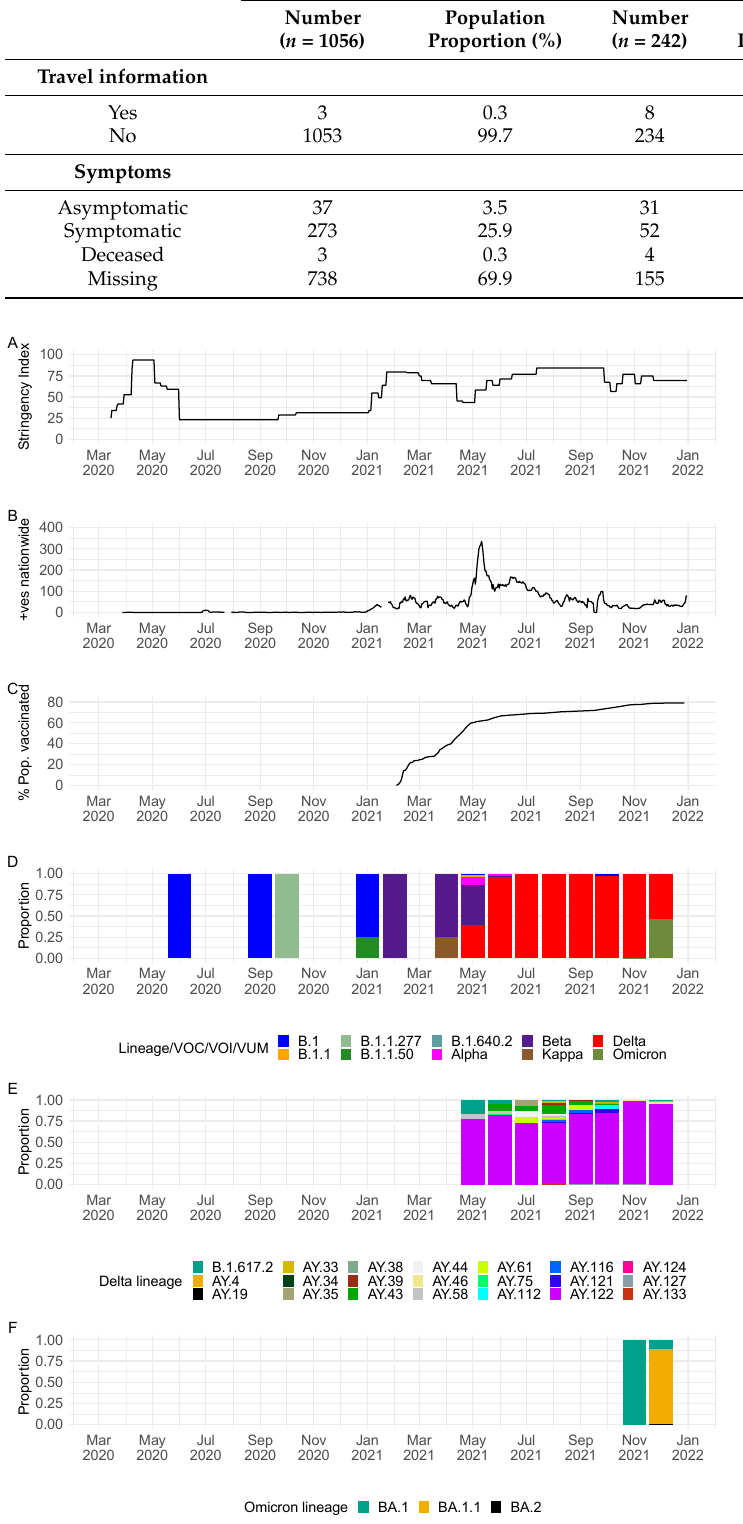
Figure 1. ( A ) Seychelles government intervention levels as measured by the Oxford stringency index [15]. ( B ) An epidemic curve for Seychelles derived from the daily positive case numbers obtained from https://ourworldindata.org/coronavirus/country/seychelles (accessed on 5 May 2022). ( C ) Percentage of the population administered with vaccine; data obtained from https://ourworldindata.org/coronavirus/country/seychelles (accessed on 5 May 2022). ( D ) Monthly temporal pattern of SARS-CoV-2 lineages and variants in Seychelles among the 1056 samples sequenced from COVID-19 positive cases from the Seychelles (25 June 2020, to 31 December 2021). ( E ) Monthly temporal distribution of Delta VOC lineages among samples sequenced from COVID- 19 positive cases from the Seychelles (25 June 2020, to 31 December 2021). ( F ) Monthly temporal